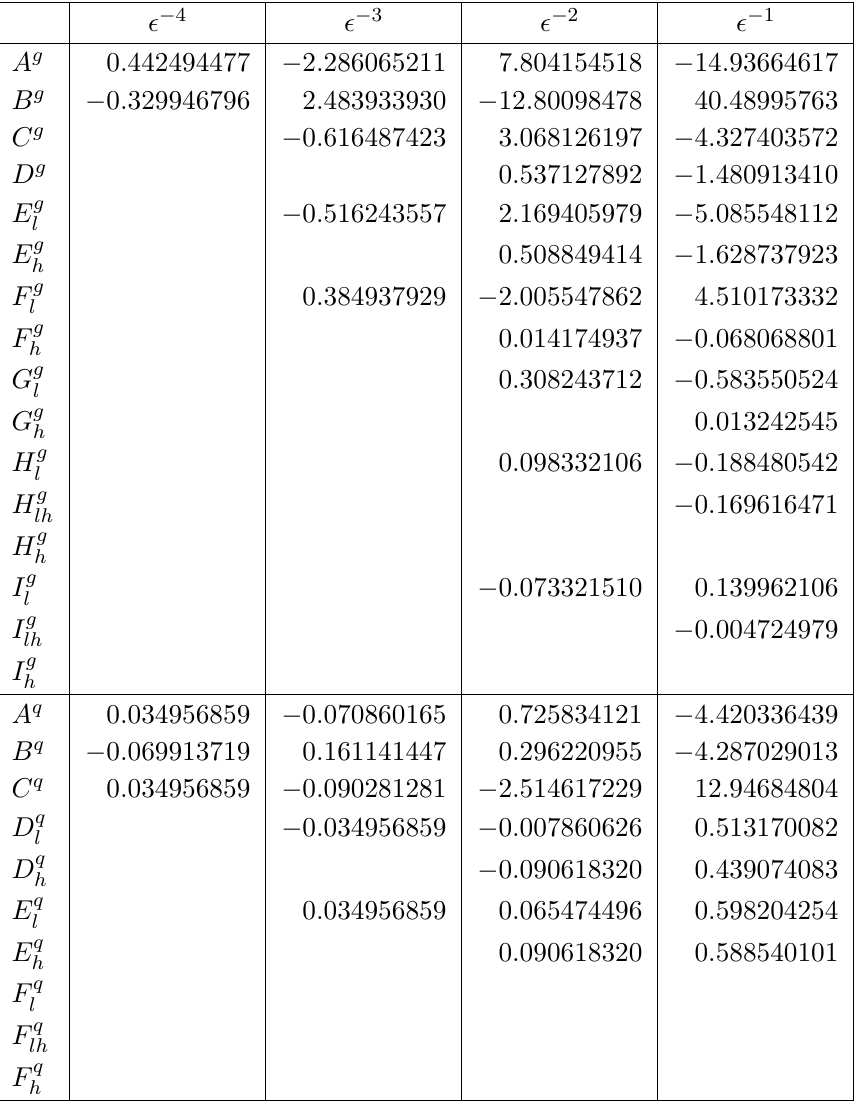
Table 2 . IR poles decomposed as color coefficients for the phase-space point x 12 = 130 , x 13